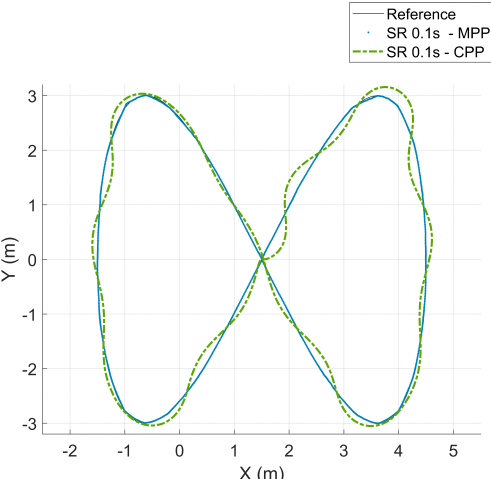
Figure 13. Pure Pursuit comparison results for a Lissajous reference.